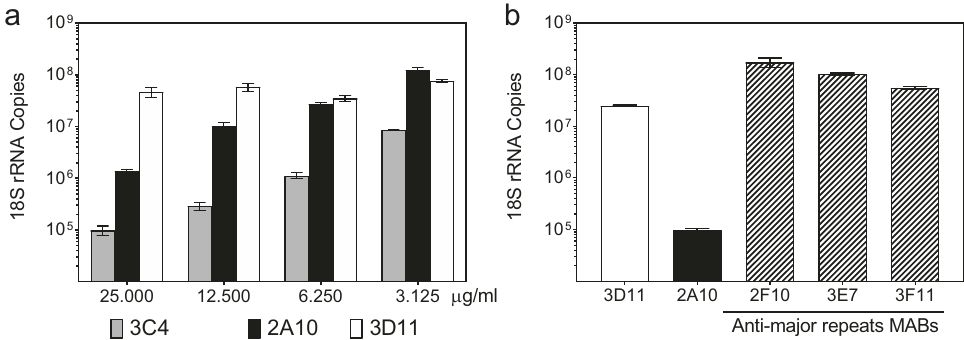
Fig. 6 Sporozoite-neutralizing activity of MAB derived from mice immunized with minor or major repeat peptides. a TSNA was carried out with varying concentrations of MAB 3C4, speci fi c for minor repeats, and MAB 2A10 that cross-reacts with minor and major repeats. MAB 3D11 speci fi c for P. berghei repeats served as negative control. Results are shown as 18 S rRNA copy number mean ± SD as measured by qRT- PCR. Incubation with MAB 3C4 resulted in statistically signi fi cant lower parasite rRNA copy number at all concentrations tested when compared to MAB 3D11 (One-way ANOVA with Dunnett ’ s test. adjusted P < 0.0001). MAB 2A10 at 25 µg/ml and 12.5 µg/ml signi fi cantly decreased 18 S rRNA copy number (one-way ANOVA with Dunnett ’ s test, adjusted P < 0.0001). b TSNA was carried out using 12.5 µg/ml of MAB speci fi c for major repeats (2F10, 3E7, 3F11), MAB 2A10 or MAB 3D11. Results are shown as mean ± SD parasite 18 S rRNA copy number as measured by qRT-PCR. The parasite rRNA copy numbers in cultures containing major repeat MABs were not decreased compared to MAB 3D11. As expected, the positive control MAB 2A10 reduced 18 S rRNA copy number >90% when compared to MAB 3D11 (one-way ANOVA with Dunnett ’ s test, adjusted P < P. falciparum sporozoite-immunized mice (Fig. 6a). In contrast,